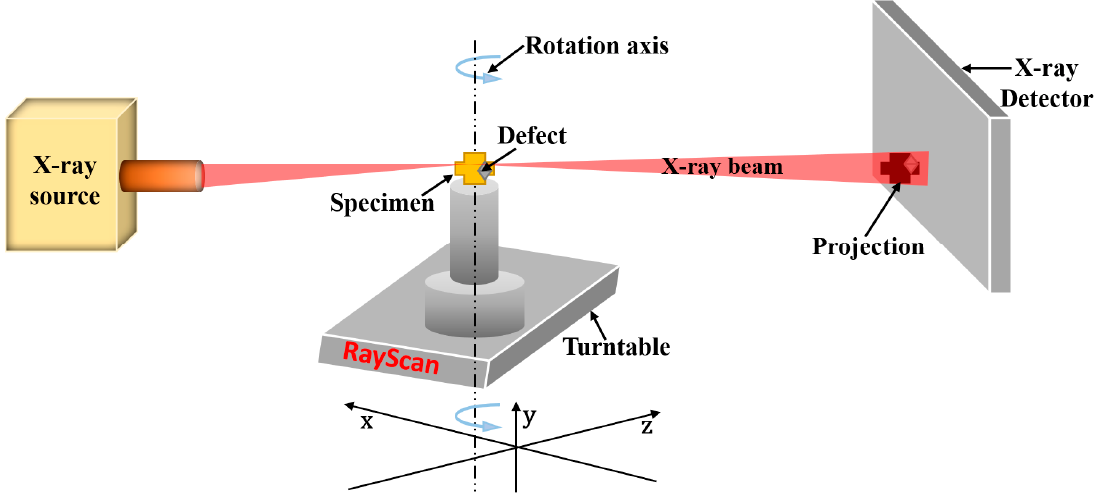
Figure 4. Schematic of experimental set-up for radiographic inspection.